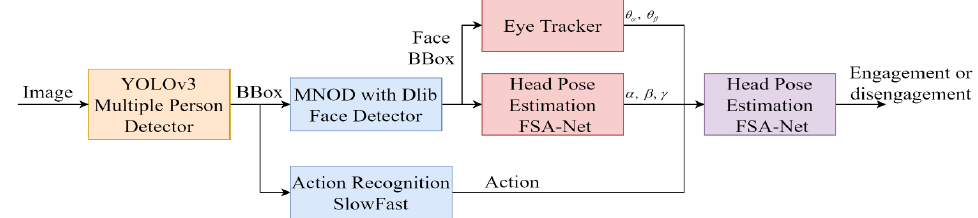
Figure 3. The architecture of the engagement model. Head Pose